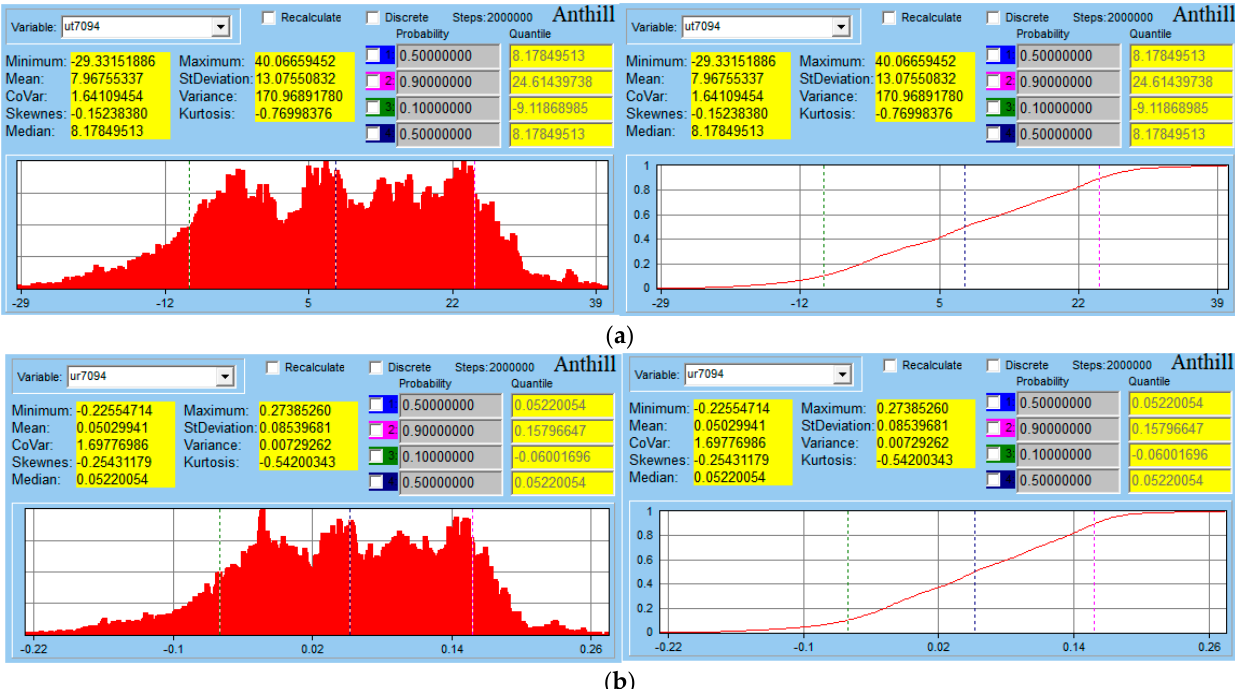
Figure 13. Histograms and distribution functions for node ‘1’ ( a ) tangential components of crustal surface displacement, ( b ) radial components of crustal surface displacement (sw MSC.Marc Mentat and Anthill).